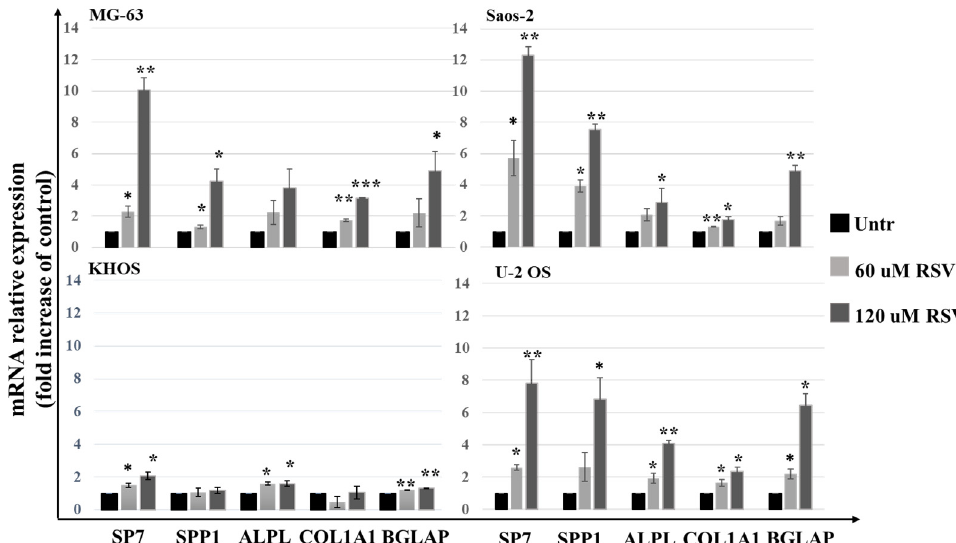
Figure 4. Evaluation of OS cell lines differentiation after RSV treatment in 48 h. qPCR analysis was performed to study the mRNA expression levels of osteoblast differentiation genes. Each bar graph shows the increase in the expression expressed in FOI compared to the control (Untreated). Gene expression analysis was performed using the 2 −ΔΔ CT method using β‐ actin expression as the reference gene (mean ± SD, n = 4). A one ‐ way ANOVA test was used to evaluate the effect of the RSV treatment factor (60 or 120 μ M) on OS cell line differentiation. Dunnett’s test: *, p < 0.05; **, p < 0.005; ***, p < 0.0005 versus untreated cell culture.